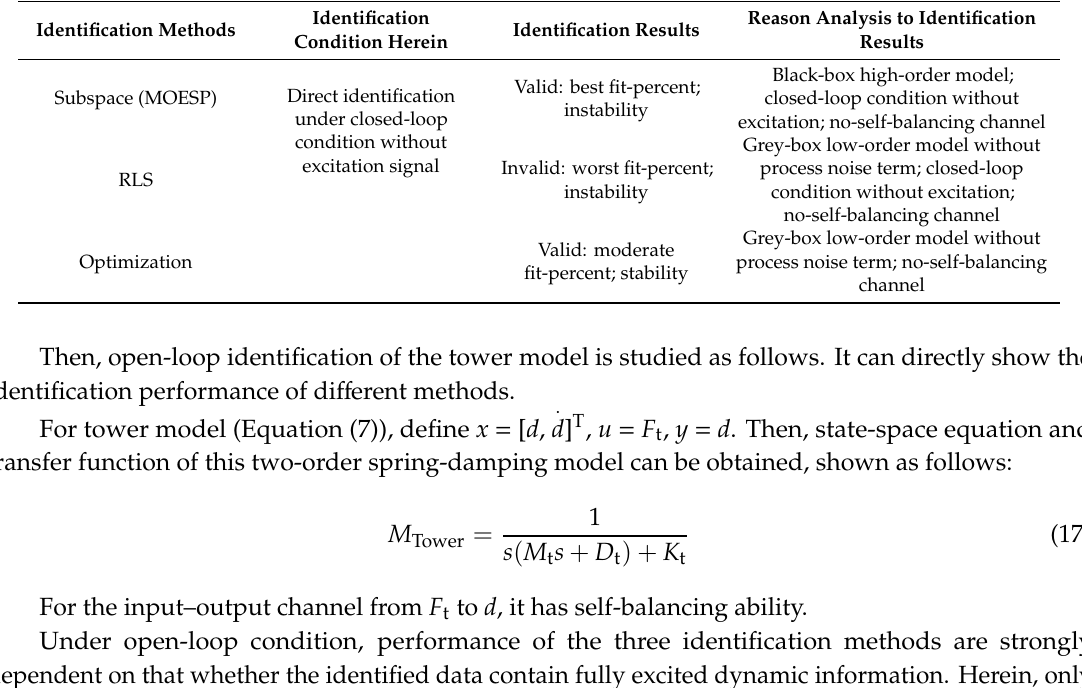
Table 6. Comparison analyses of identification results for two-mass